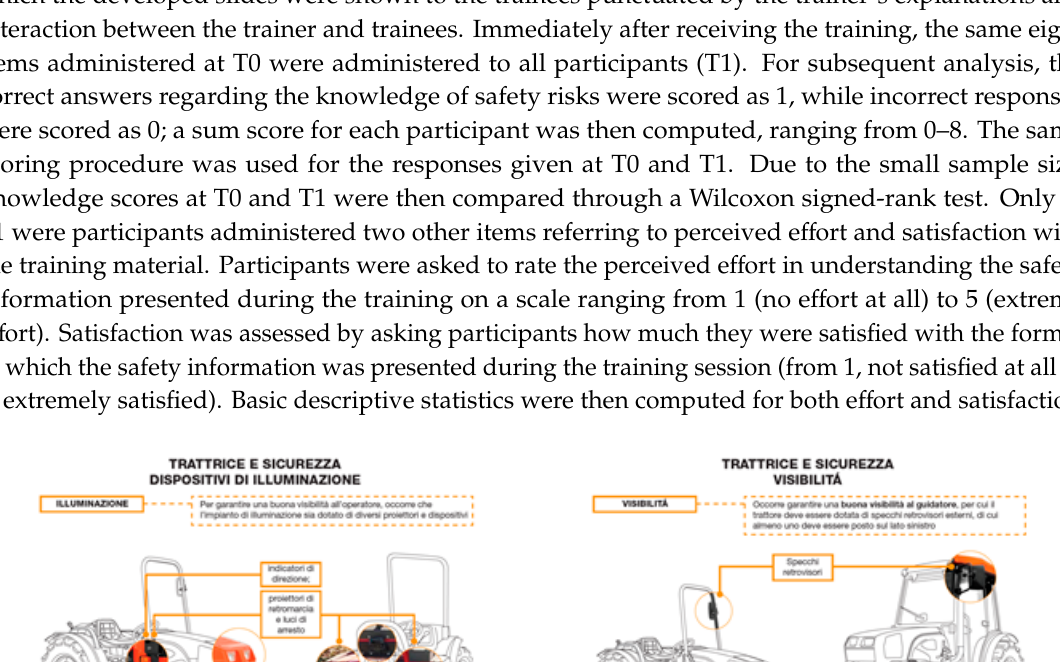
Figure 2. Slides about “what to do in case of electrical shock” shown to migrant farmworkers: a basic animation was added to the slide to explain the correct behaviour to be performed in four different steps: ( a ) turn off the flow of electricity; ( b ) remove the wire or the electrocuting appliance or source with a wooden stick; ( c ) call local emergency; ( d ) do no t touch someone who has been shocked if they are still in contact with the source of electricity.